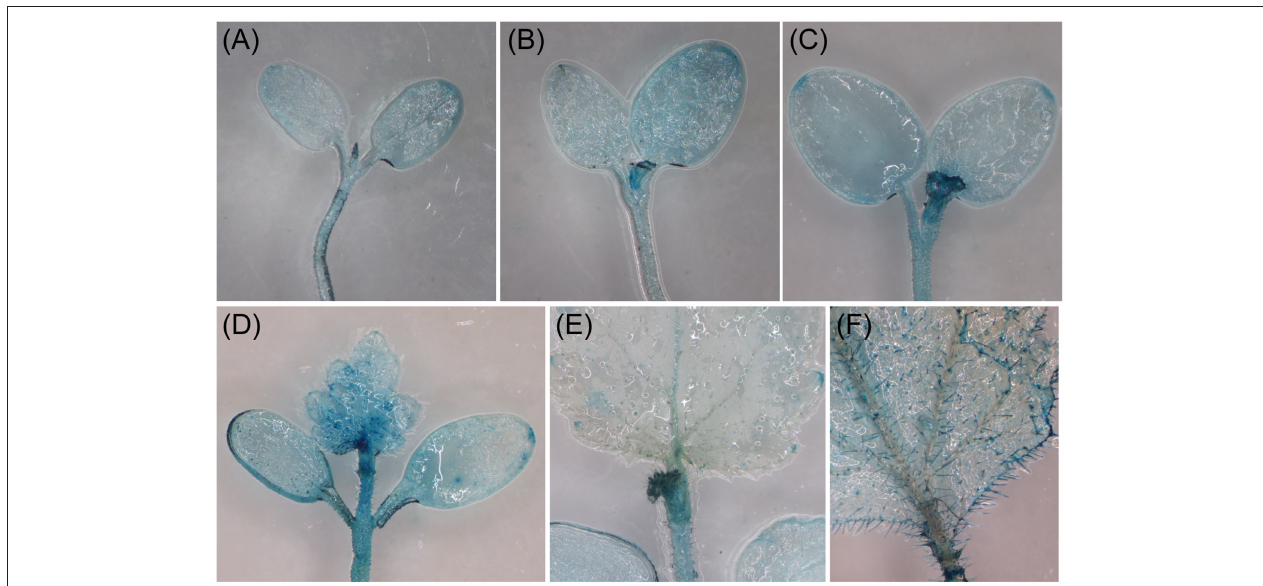
FIGURE 4 | Analysis of the expression pattern of BpMYB106 in birch by the transient gene expression system. (A), 5-d-old seedling; (B) , 7-d-old seedling; (C) , 10-d-old seedling; (D) , 14-d-old seedling; (E) , 21-d-old seedling; (F) , mature leave of 50-d-old seedling.